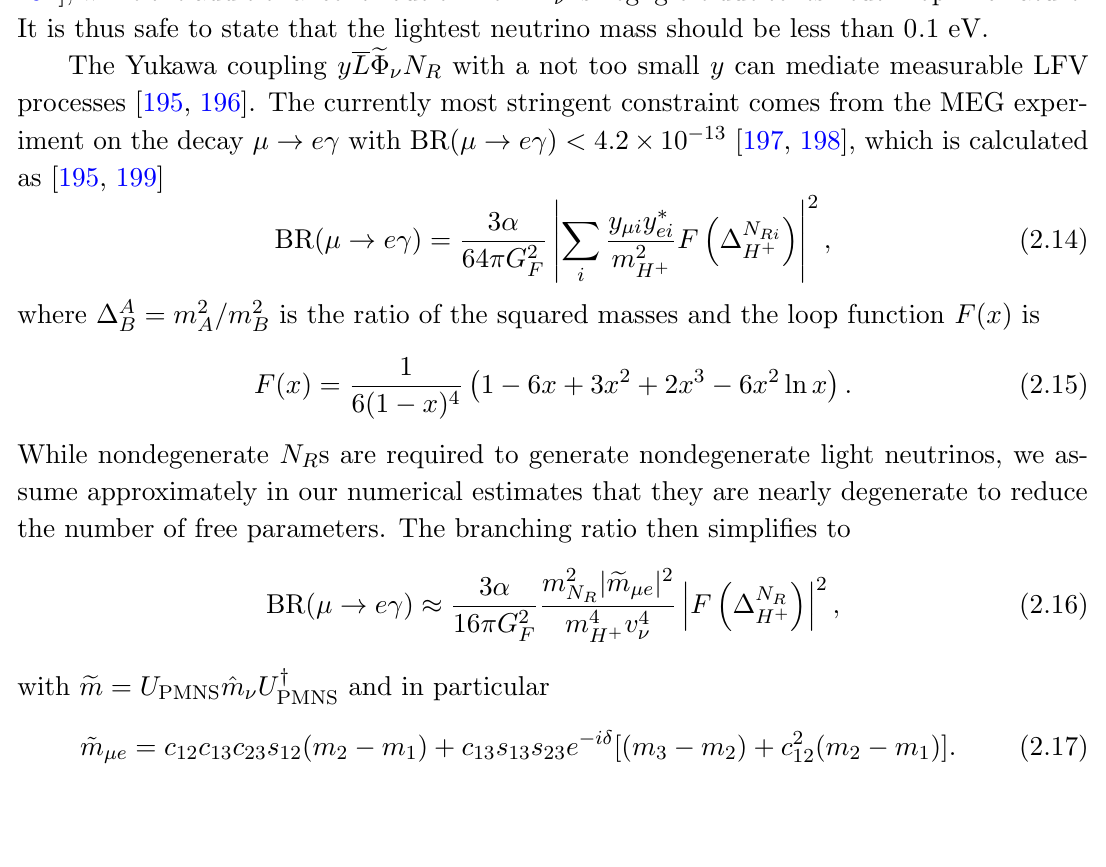
; m N ) = (300 ; 200) H + R